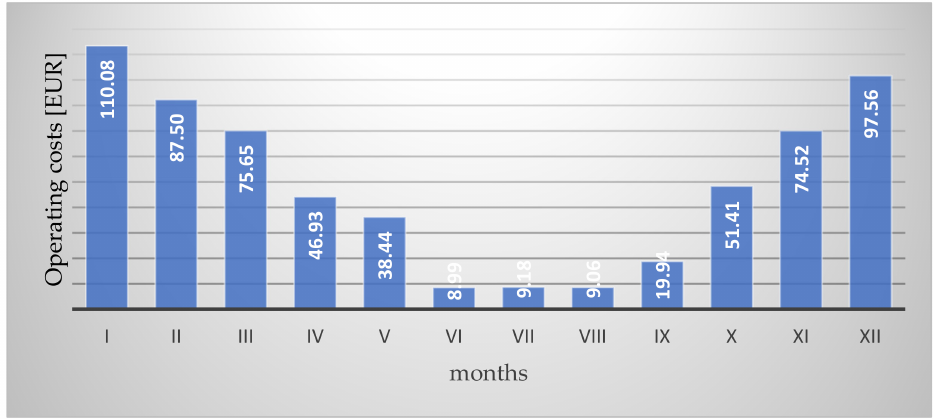
Figure 2. Summary of monthly costs for the electricity used to drive the heat pump compressor. Source: own study.